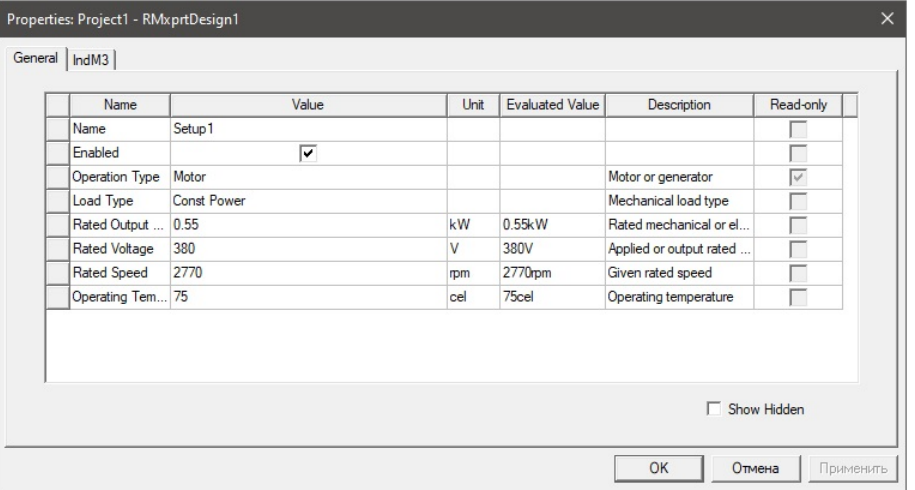
Figure 9. End connections in stator winding.